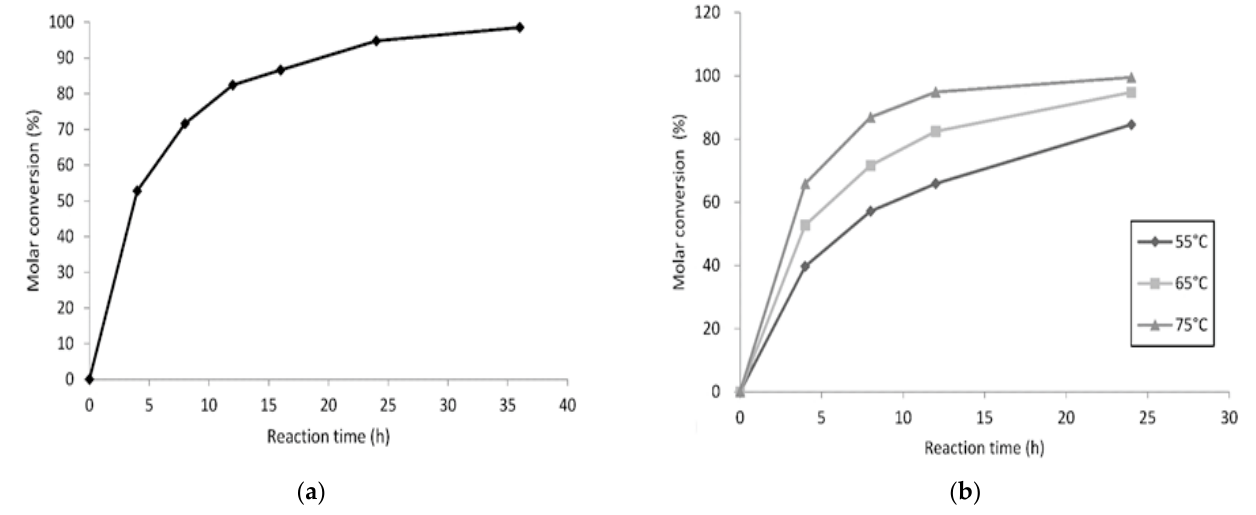
Figure 3. Effects of ( a ) reaction time, and ( b ) temperature, on the molar conversion of octyl cinnamate.